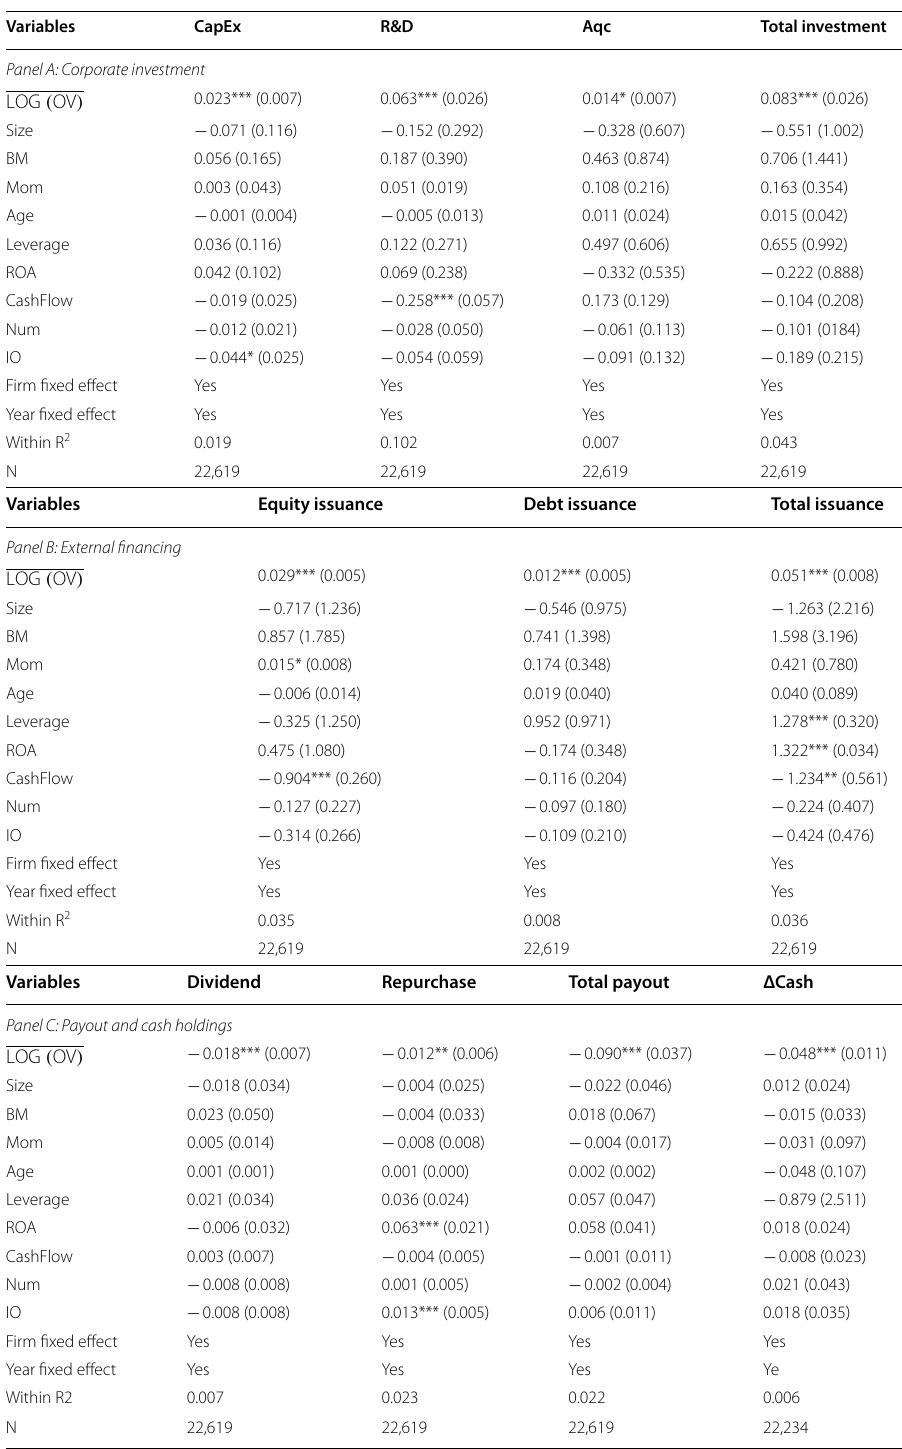
Table 6 Instrumental variable